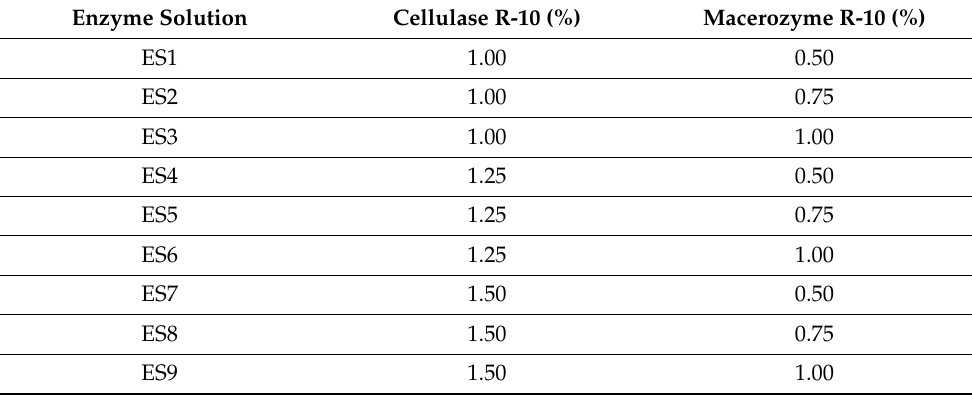
Table 3. Different concentrations of cellulase R-10 and macerozyme R-10 for the preparation of the enzyme solutions. Enzyme Solution Cellulase R-10 (%) Macerozyme R-10 (%) ES1 1.00 0.50 ES2 1.00 0.75 ES3 1.00 1.00 ES4 1.25 0.50 ES5 1.25